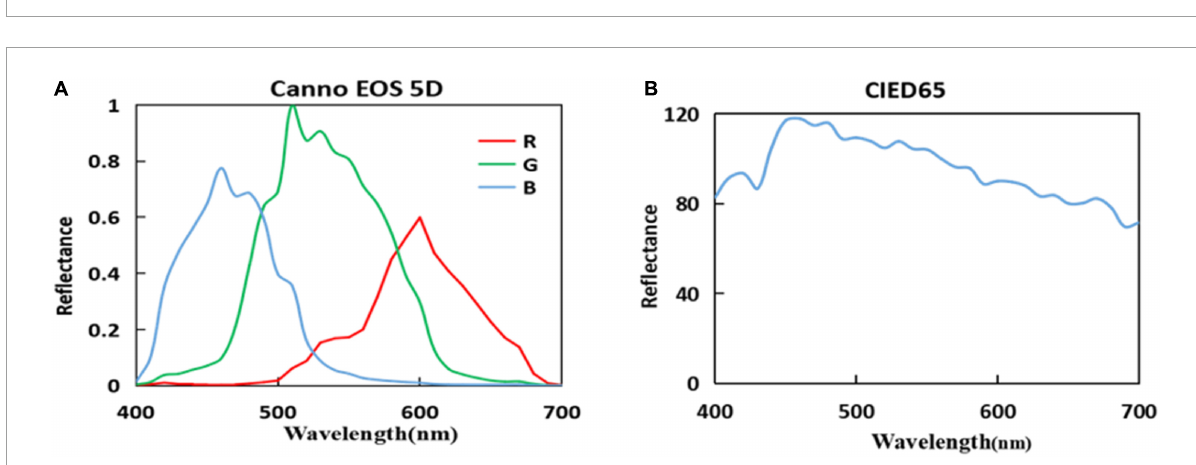
FIGURE2 (A) Spectral sensitivities of the camera and (B) spectral power distribution of the International Commission on Illumination (CIE) Standard Illuminant